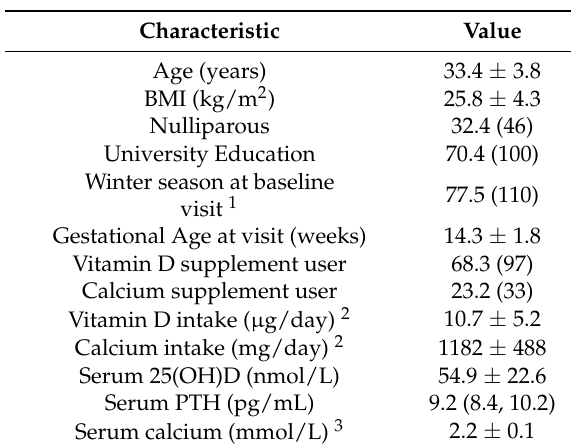
Table 1. Sample characteristics of participants ( n =